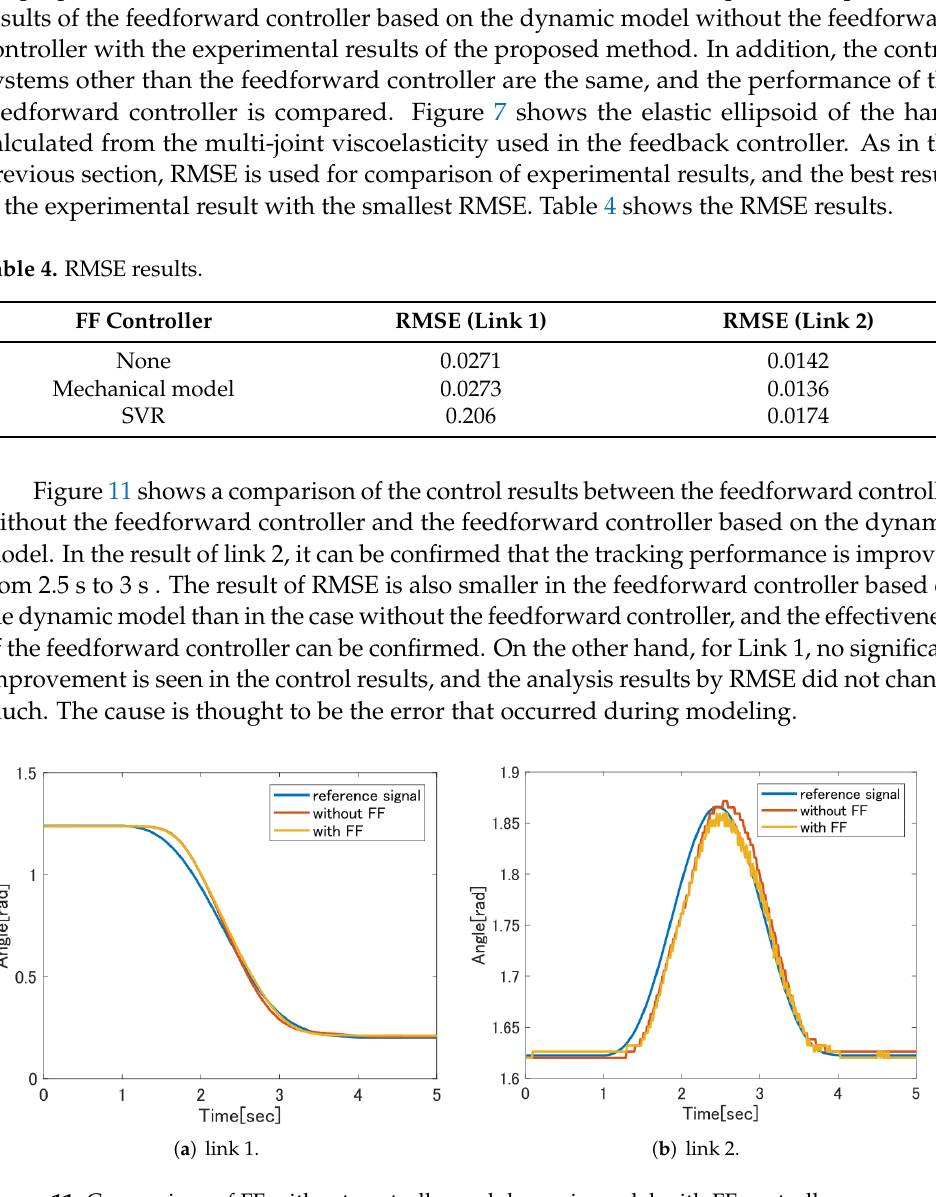
Figure 11. Comparison of FF without controller and dynamic model with FF